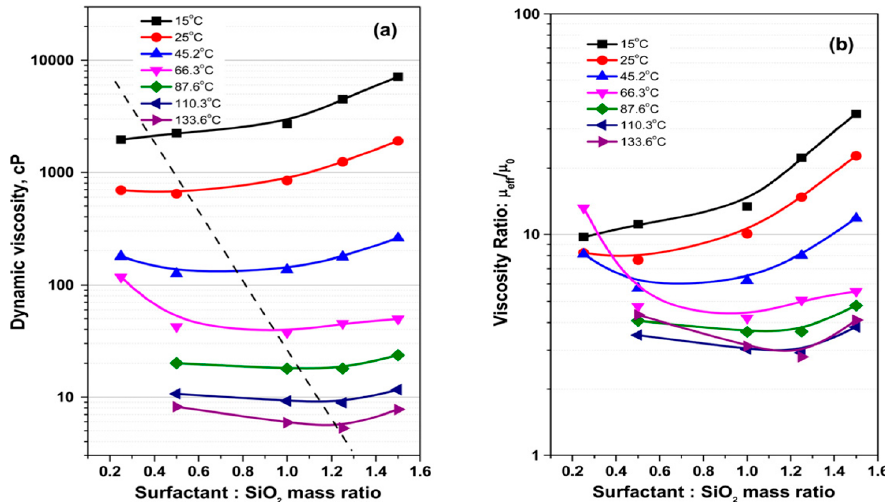
Figure 7. ( a ) Viscosity; and ( b ) viscosity ratio of 5 vol% SiO 2 /TH66 suspensions at various surfactant ‐ to ‐ nanoparticle ratios. Viscosity values at 20 D/cm 2 shear stress are used to compare the results at various temperatures and suspension compositions [56].